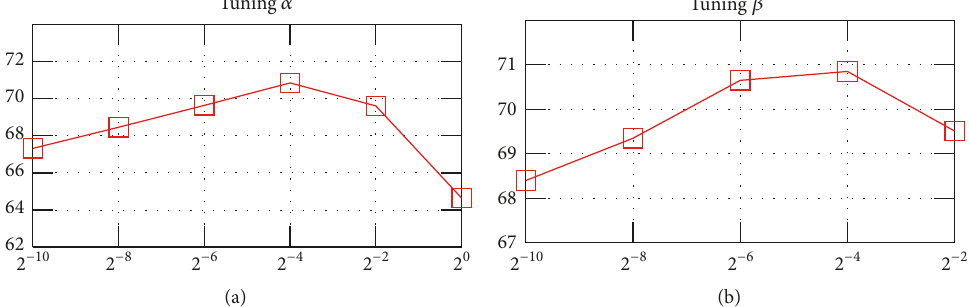
Figure 11: Parameter tuning on Oxford-102 database with Hellinger kernel. (a) Tuning 𝛼 with 𝛽 = 2 −4 . (b) Tuning 𝛽 with 𝛼 = 2 −4 .